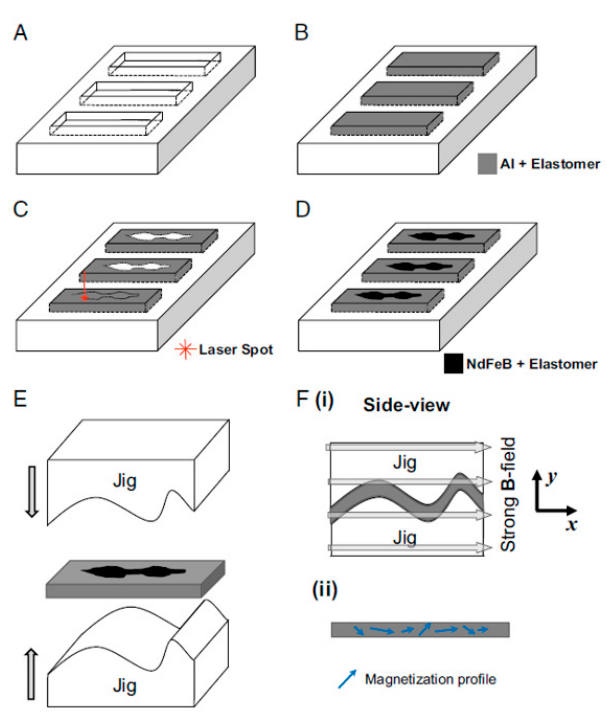
Figure 8. The manufacturing process of magnetic soft materials in the study by Lum, Ye, Dong, Marvi, Erin, Hu and Sitti [44]. ( A ) a negative mold; ( B ) the passive component; ( C ) laser cutting; ( D ) NdFeB and Elastomer poured and cured in the mold ( E ) the beam bent into the jig; ( F i) the beam is magnetized with a strong B field (~1 T); (ii) the beam is removed from the jig. Kim et al. [15] reported one of the first 3D printing magnetic responsive materials by incorporating magnetic microparticles (NdFeB) in a soft compound and printing non-uniform magnetization patterns. This was previously done by embedding whole magnets into a soft compound. Their printing method was based on direct ink writing. During the printing procedure, a static magnetic field was applied at the nozzle to reorient the particles along that field (see Figure 9a) generated by either a permanent magnet or an electromagnet. The magnetic shield between the electromagnet and the printed material weakened the magnetic field from the electromagnet, so that the printed magnetic patterns were not disturbed by it. This ink with its created magnetic field directions could then be used to print complex structures, Figure 9b, which enabled structures that were not possible to make before. For the shape change activation, a permanent magnet was used. The magnetic responsive soft material could react fast, untethered, and in a revered way. They found that with the increase of the applied field at the nozzle tip, the magnetic moment density of produced samples through nozzles improved. Furthermore, the effect of nozzles’ diameters on the magnetic moment density was investigated with their custom-made set-up.